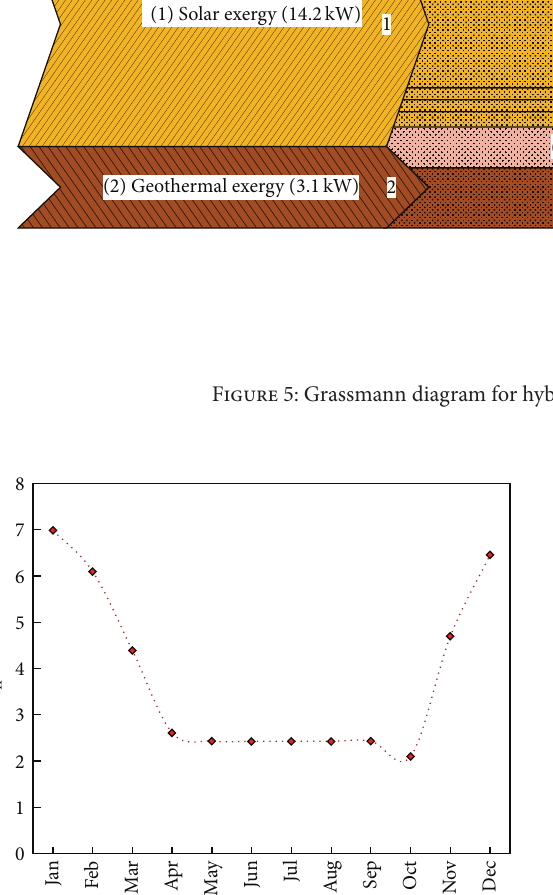
Figure 6: Exergy efficiency of integrated SPV and GSHP for different months.